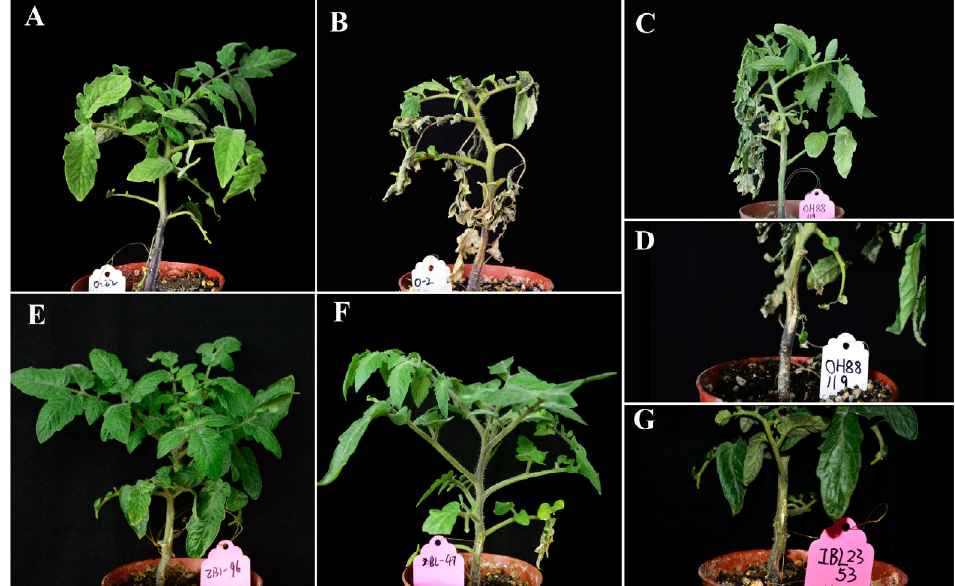
Figure 1. Symptoms of bacterial canker in resistant inbreeding line IBL2353 and susceptible S. lycopersicum Ohio88119 infected with the Cm GS12102 strain. ( A ) Ohio88119 plant at 30 days after mock inoculation. ( B ) Ohio88119 plant showed the wilting of whole plant at 30 days after Cm inoculation. ( C ) Unilateral wilting of the whole plant in Ohio88119 at 25 days after Cm inoculation. ( D ) Long and cracking canker on the injection sites of susceptible line at 30 days after Cm inoculation. ( E ) IBL2353 plant at 30 days after mock inoculation. ( F ) IBL2353 plant with mild leaflet wilting at 30 days after Cm inoculation. ( G ) Small and mild canker wound on the injection sites of resistant line at 30 days after Cm inoculation.